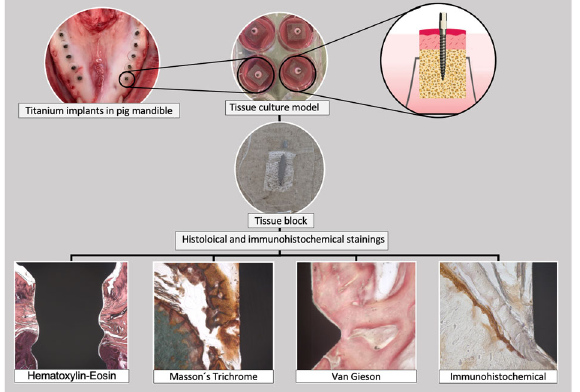
Fig.a.b.c.d.e.f.g As a pre-selected image for the cover, I really look forward to being selected. Special thanks to you for your